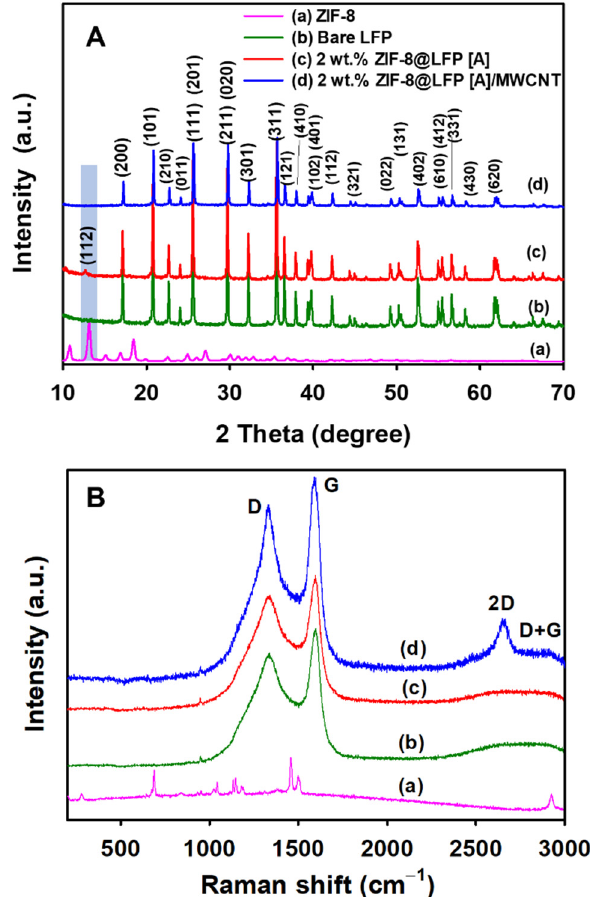
Figure 3. ( A ) XRD patterns of the pure ZIF-8 (a), bare LFP (b), 2 wt.% ZIF-8@LFP [A] (c), and 2